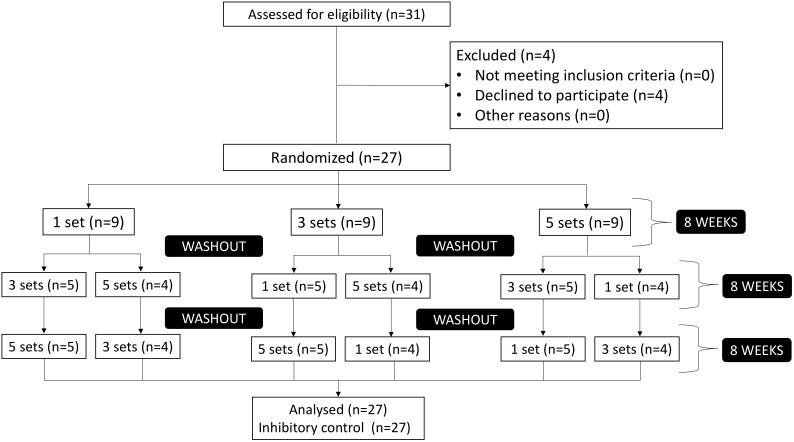
Flowchart of analyzed participants.